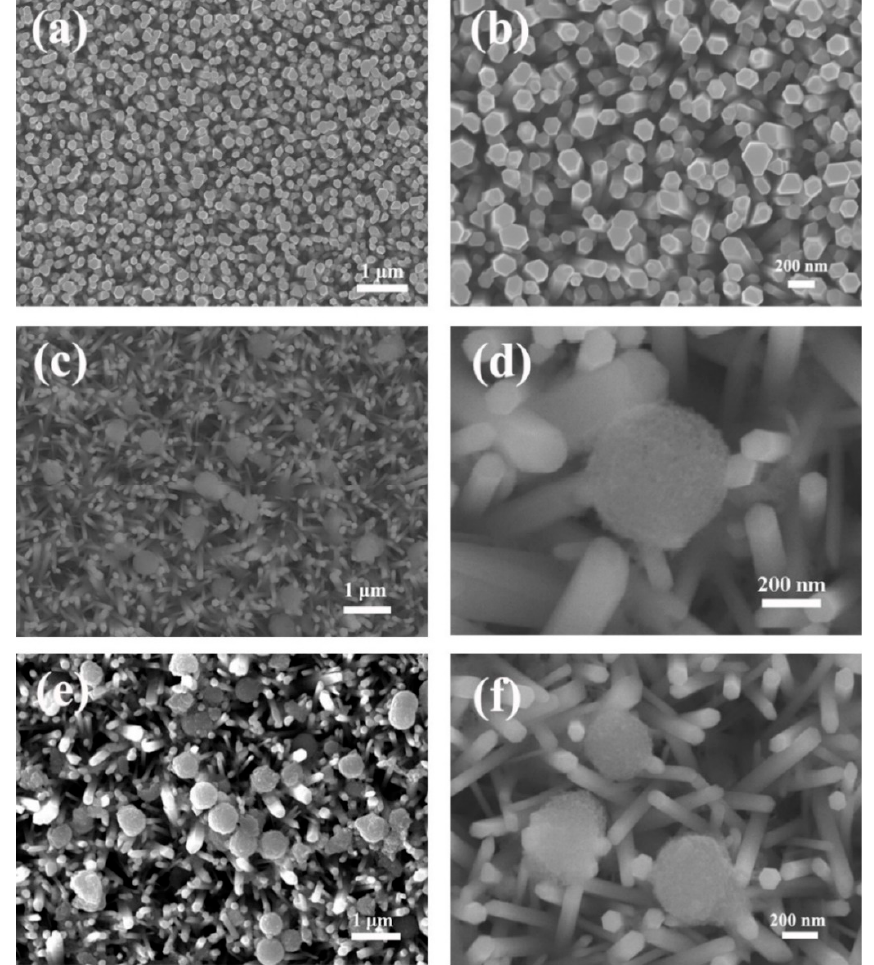
Figure 1. Typical top view SEM images of pure ZnO ( a , b ), ZnO/TiO 2 ( c , d ), ZnO/TiO 2-X ( e , f ) samples on the FTO substrate.